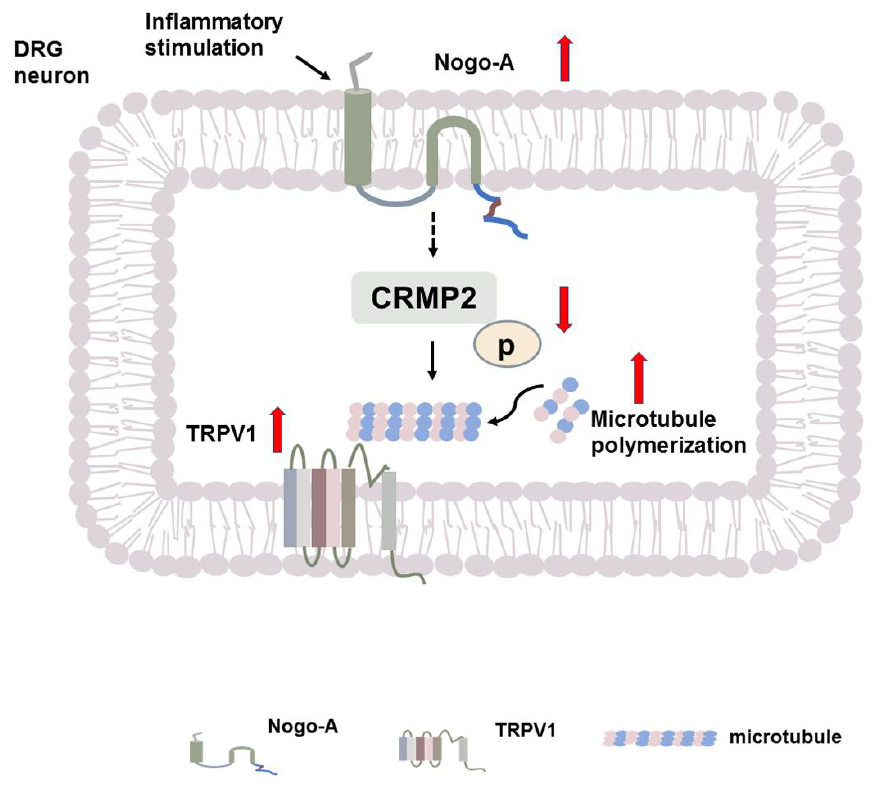
Figure 6. A model for the regulation of microtubule by Nogo-A in inflammatory heat hyperalgesia. The inflammatory stimulation elevated the Nogo-A expression in DRG neurons in the CFA-induced inflammatory pain [5]. Nogo-A in DRG neuron inhibits the phosphorylation of CRMP2 and increases the activity of CRMP2. The active CRMP2 enhances the polymerization of microtubules, which supports the function of TRPV1 and contributes to the development of inflammatory